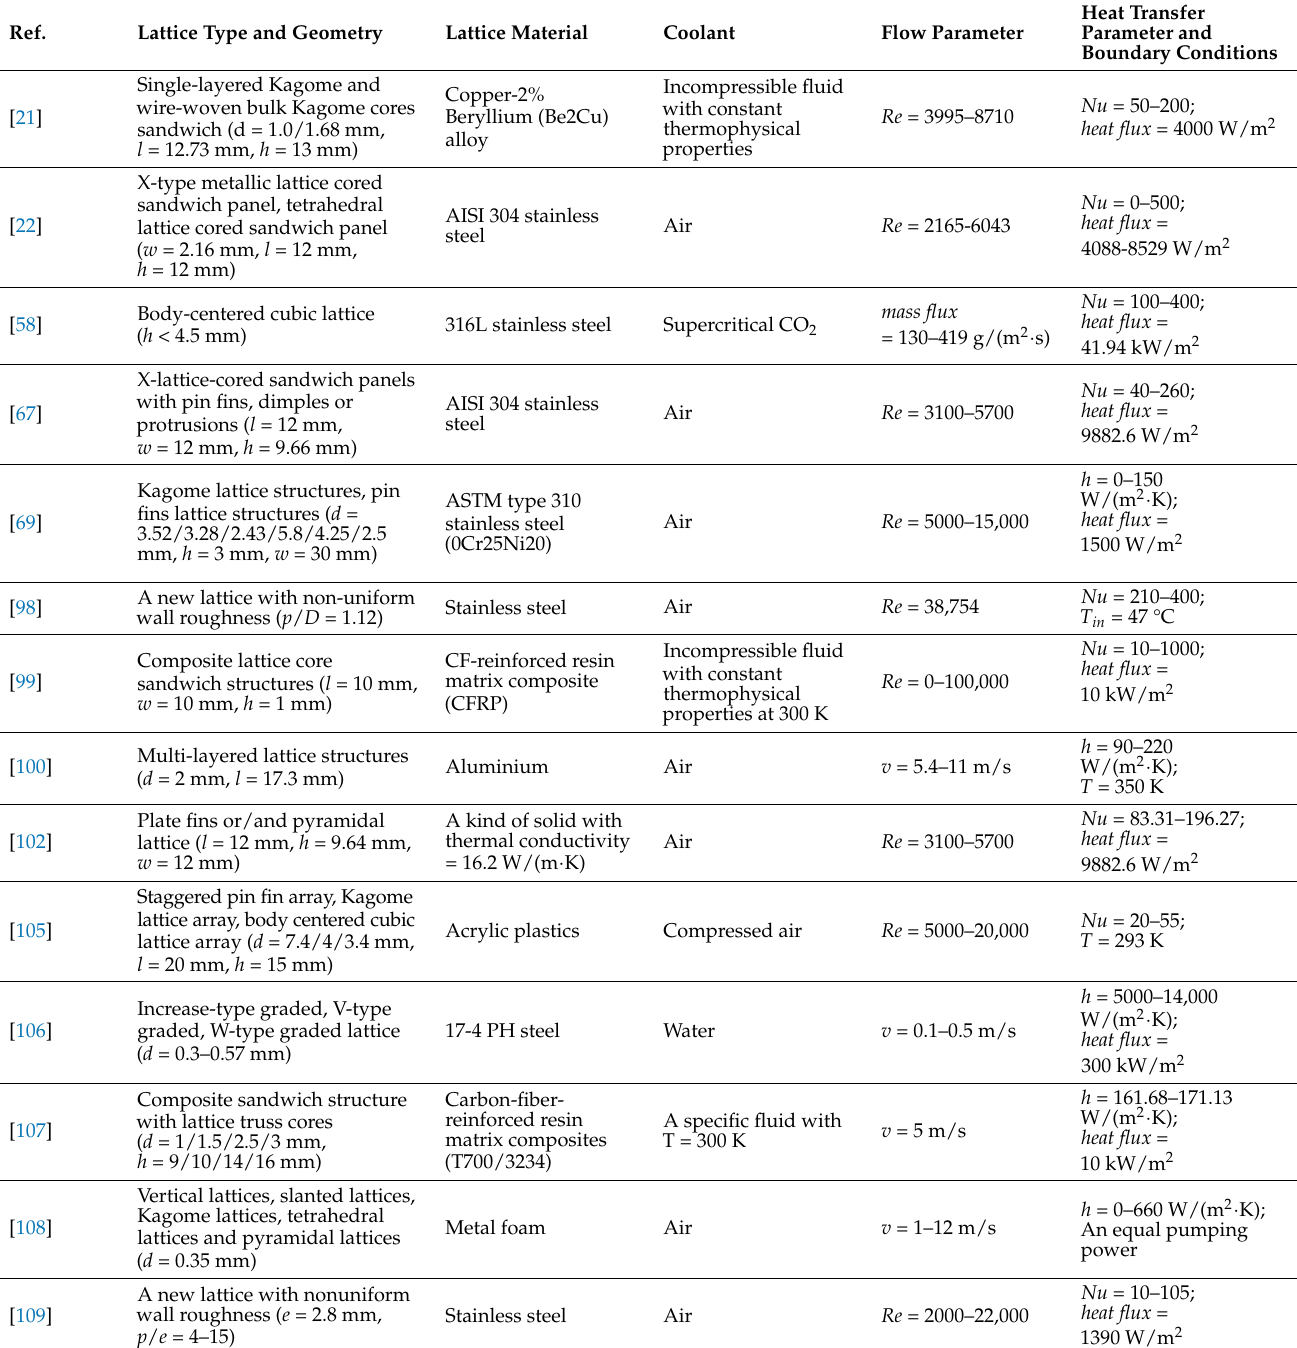
Table 2. Literature on different elements and related parameters of porous/lattice